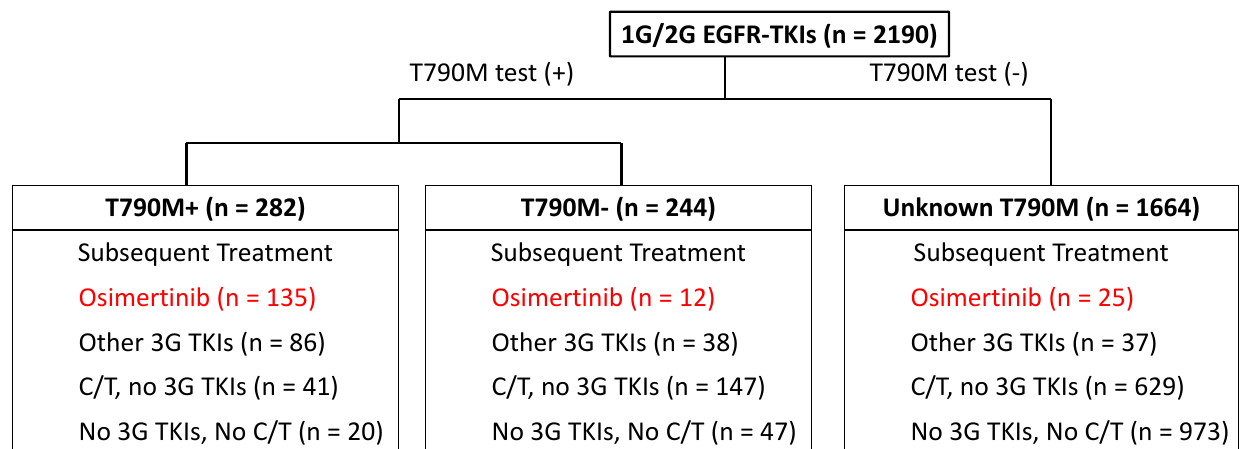
Figure 1. The summary of subsequent treatment following afatinib-based T790M mutation.